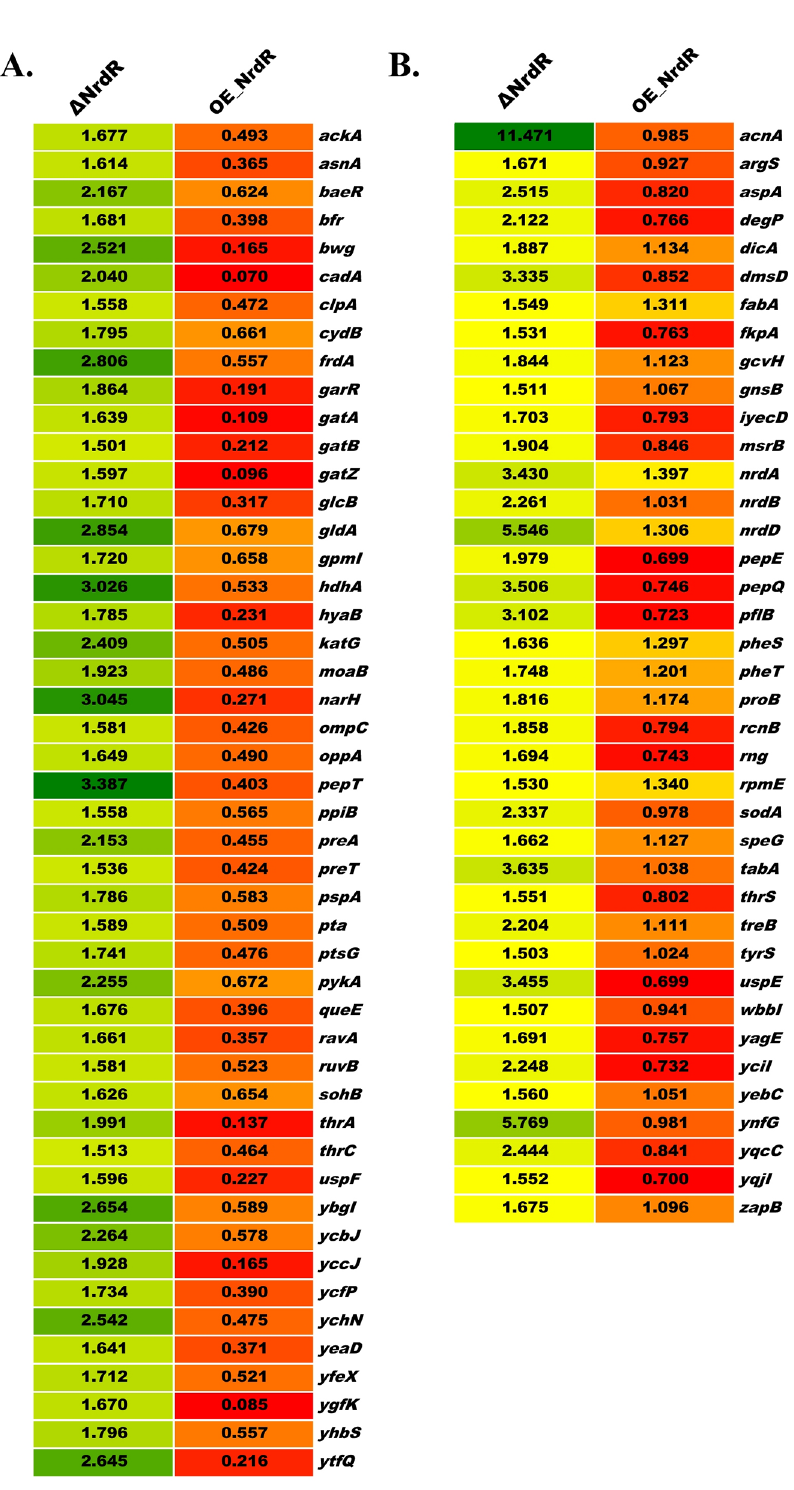
Fig 5. Heat maps representing differential regulation of proteins in E . coli following NrdR-deletion and -overexpression. (A) Protein categories upregulated in the Δ NrdR strain but downregulated in the OE-NrdR strain. (B) Protein categories upregulated in the Δ NrdR strain but with no change for the OE-NrdR strain. The color scale indicates differential regulation of protein amounts relative to WT E . coli control, with upregulation indicated by green shading and downregulation by red. Genes are listed